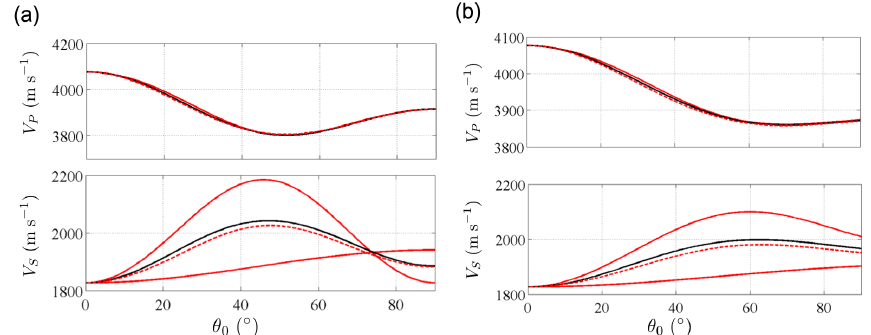
Figure 4. Illustration of the inconsistency of the velocity averaging method for the two VTI textures shown in Fig. 2a and b. The velocities V P and V S are reported as functions of θ 0 , from the effective medium theory (black curves) and from the velocity averaging method (plain red lines). The dotted red lines show the shear wave velocity from Bennett’s expression, close to the harmonic mean of the two unphysical shear wave velocities in plain red